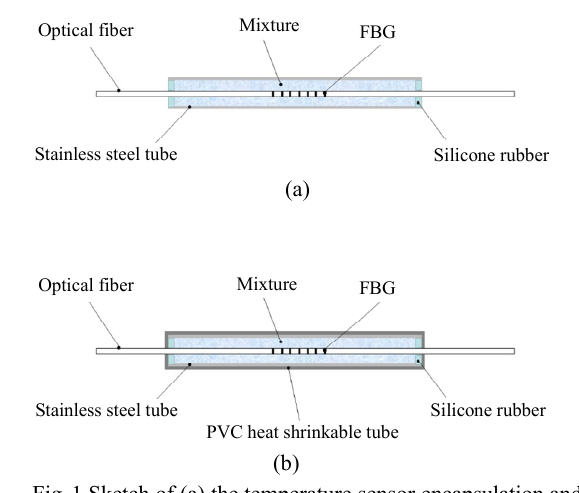
Fig. 1 Sketch of (a) the temperature sensor encapsulation and (b) the temperature compensation sensor encapsulation.